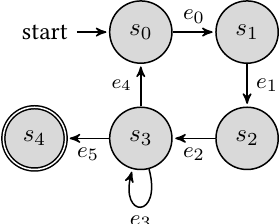
Figure 4. The sample finite state machine M j